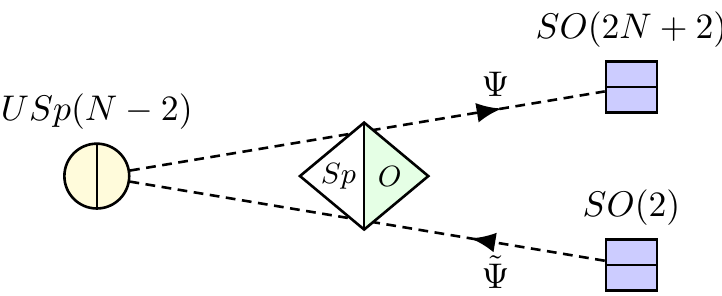
Figure 23. The abstract quiver for a partial gauging of a q a flow to the R 2 ,N − 1 (even N ) CFT plus a decoupled chiral multiplet. The oppositely directed arrows on the meson lines Ψ , ˜Ψ indicate that the q